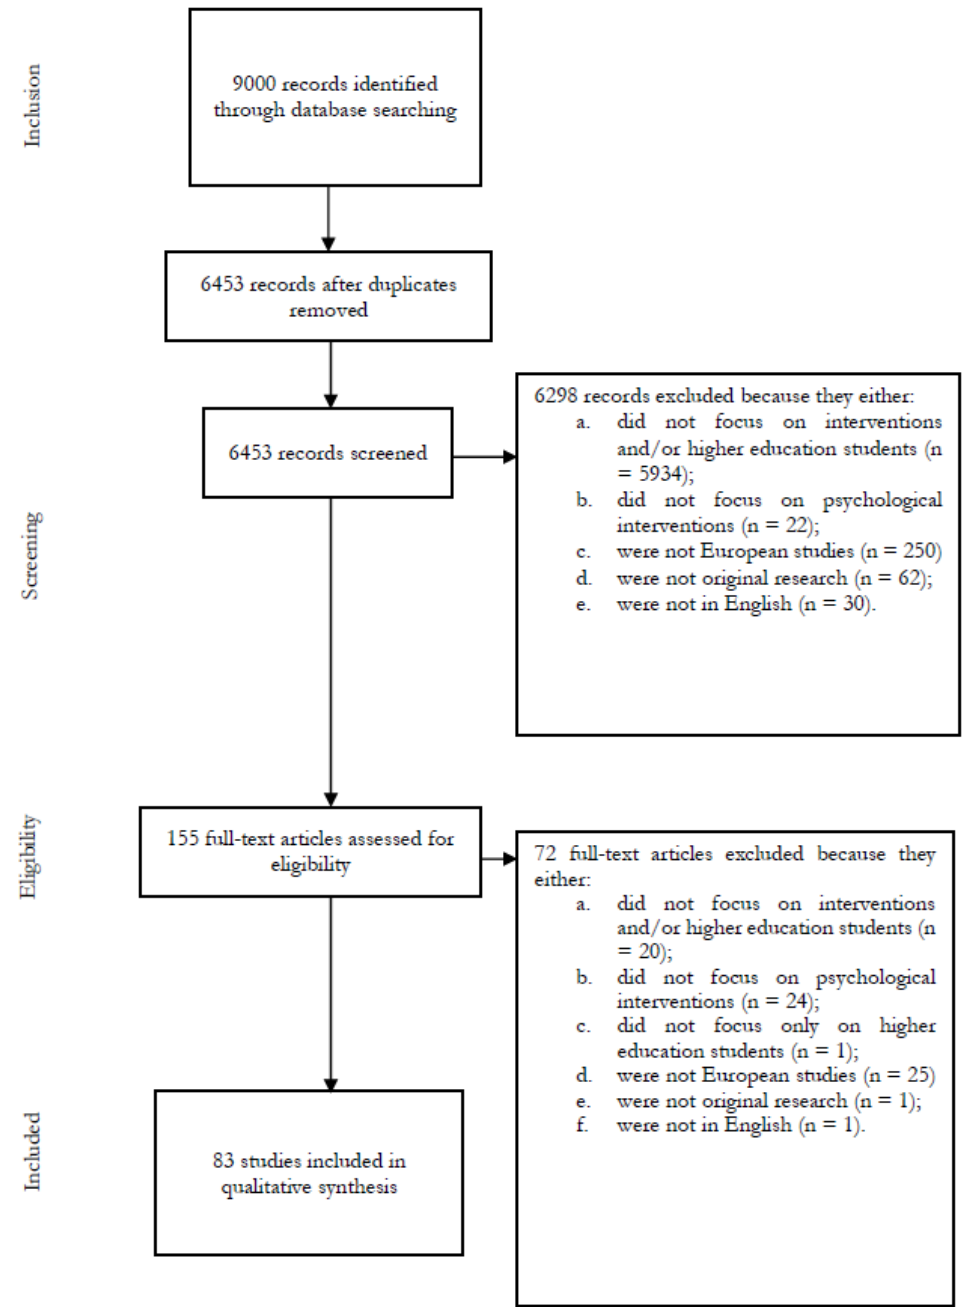
Figure 1. Flow of information through the different phases of the review process.